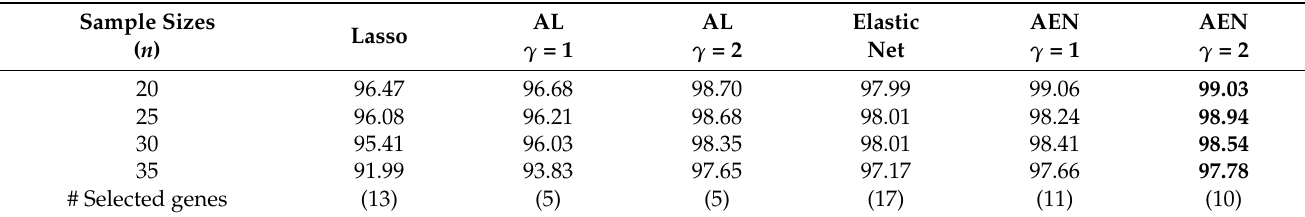
Table 9. The average percentage of accuracy and the average number of selected genes of lasso, adaptive lasso (AL), elastic net, and adaptive elastic net (AEN) under 40 leukemia genes.